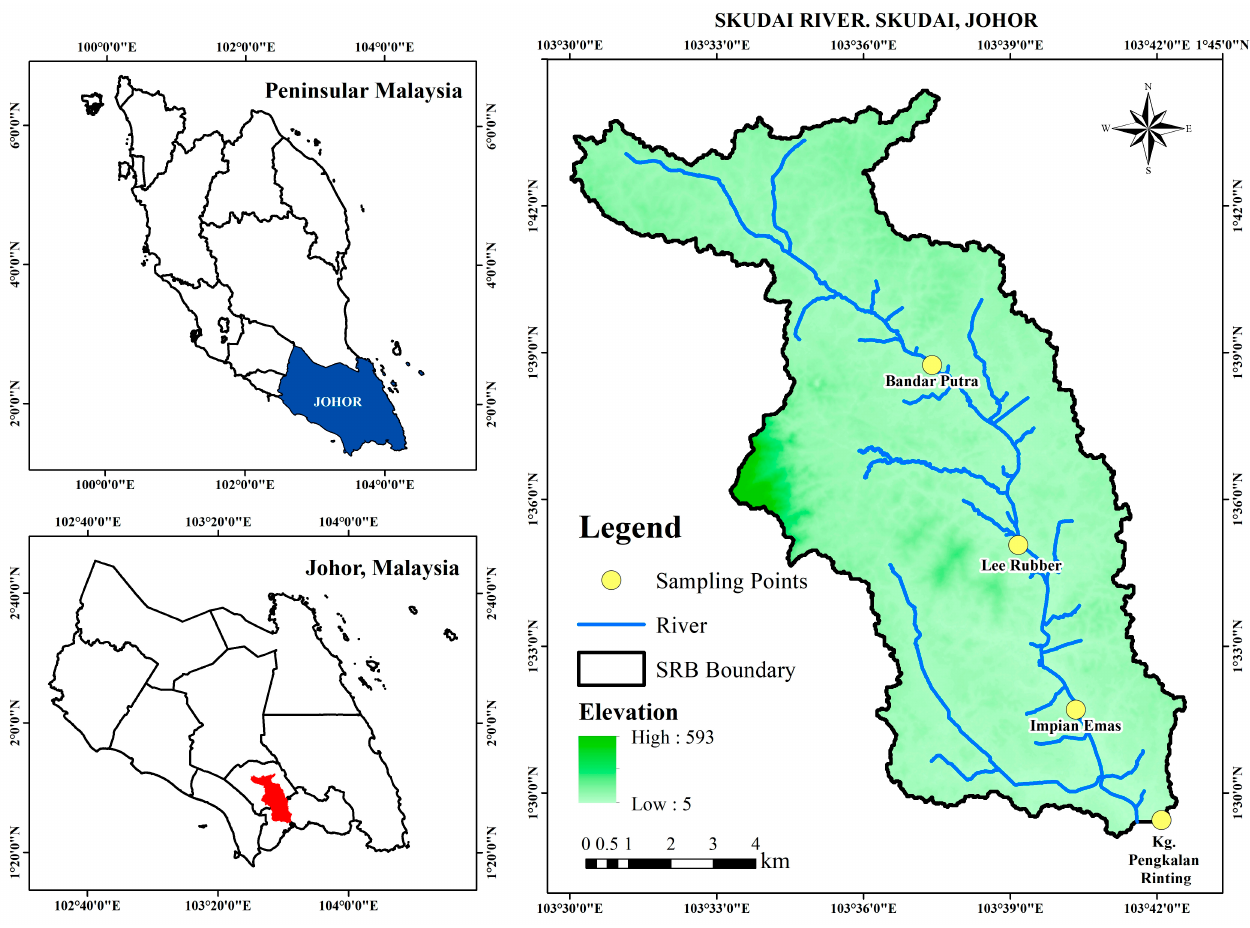
Figure 1. Location of sampling stations along Skudai River.